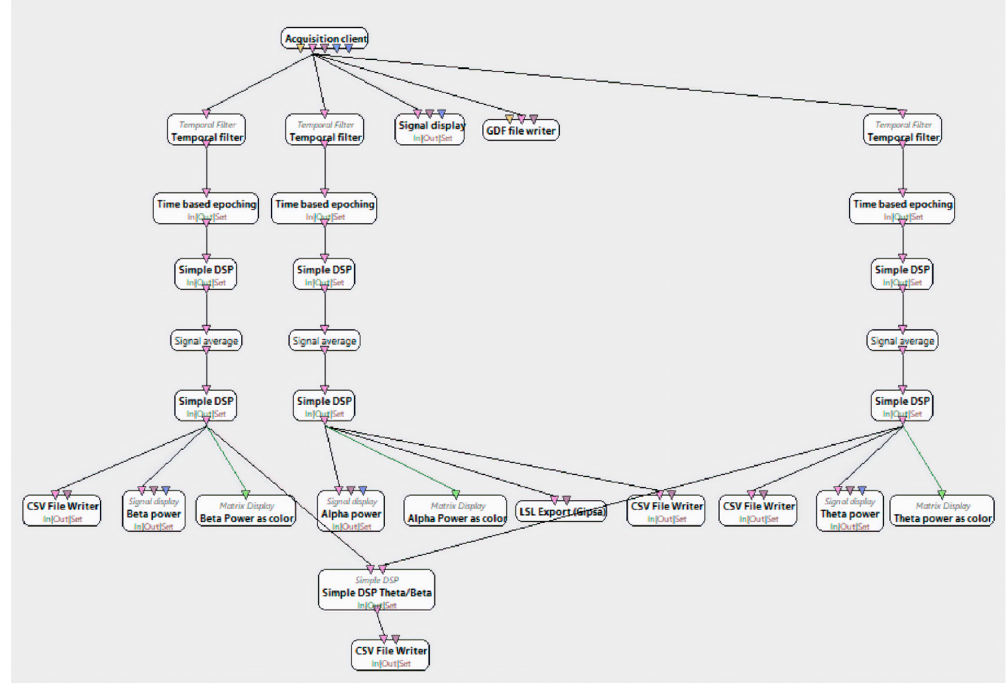
Figure 3. EEG signal recording and decomposition in frequency bands.